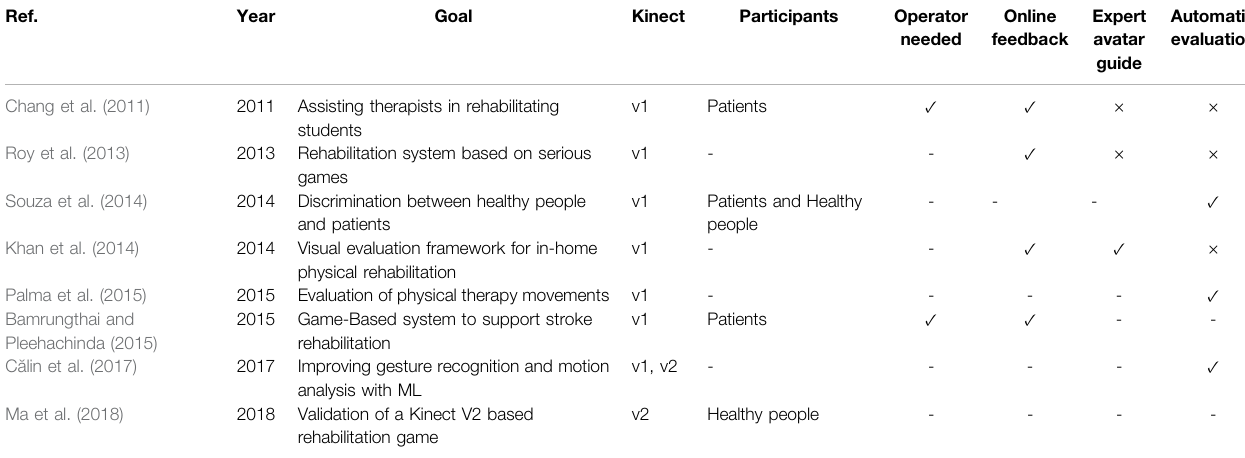
TABLE 4 | Comparative analysis of approaches similar to 2Vita-B Physical proposed in the literature.